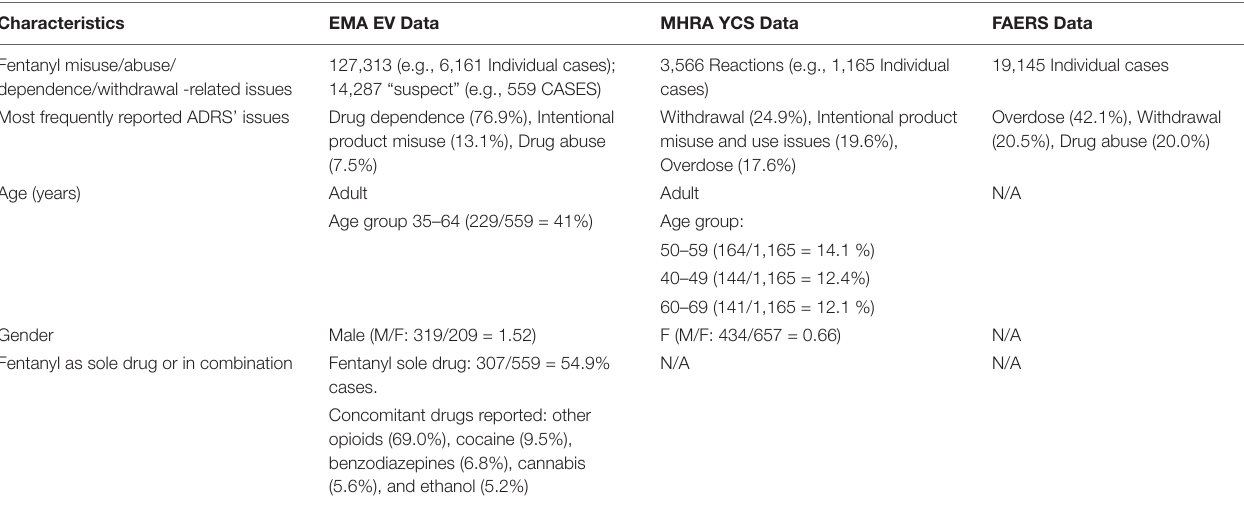
TABLE 1 | Data relating to fentanyl misuse/abuse/dependence/withdrawal-related ADRs reported to the European Medicines Agency (EMA), the Medicines and Healthcare products Regulatory Agency (MHRA), and the Food and Drug Administration (FDA) pharmacovigilance databases, 2004–2018.